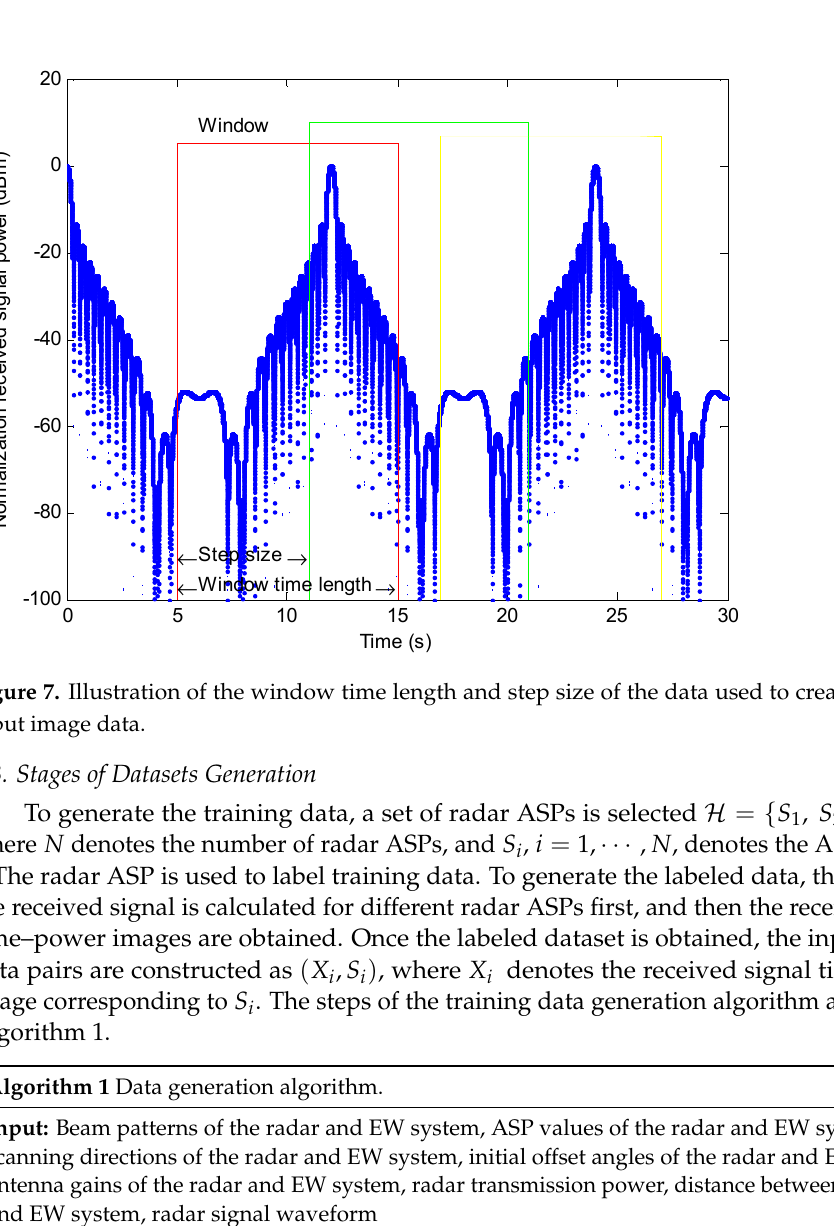
Figure 6. The block diagram of the proposed method.